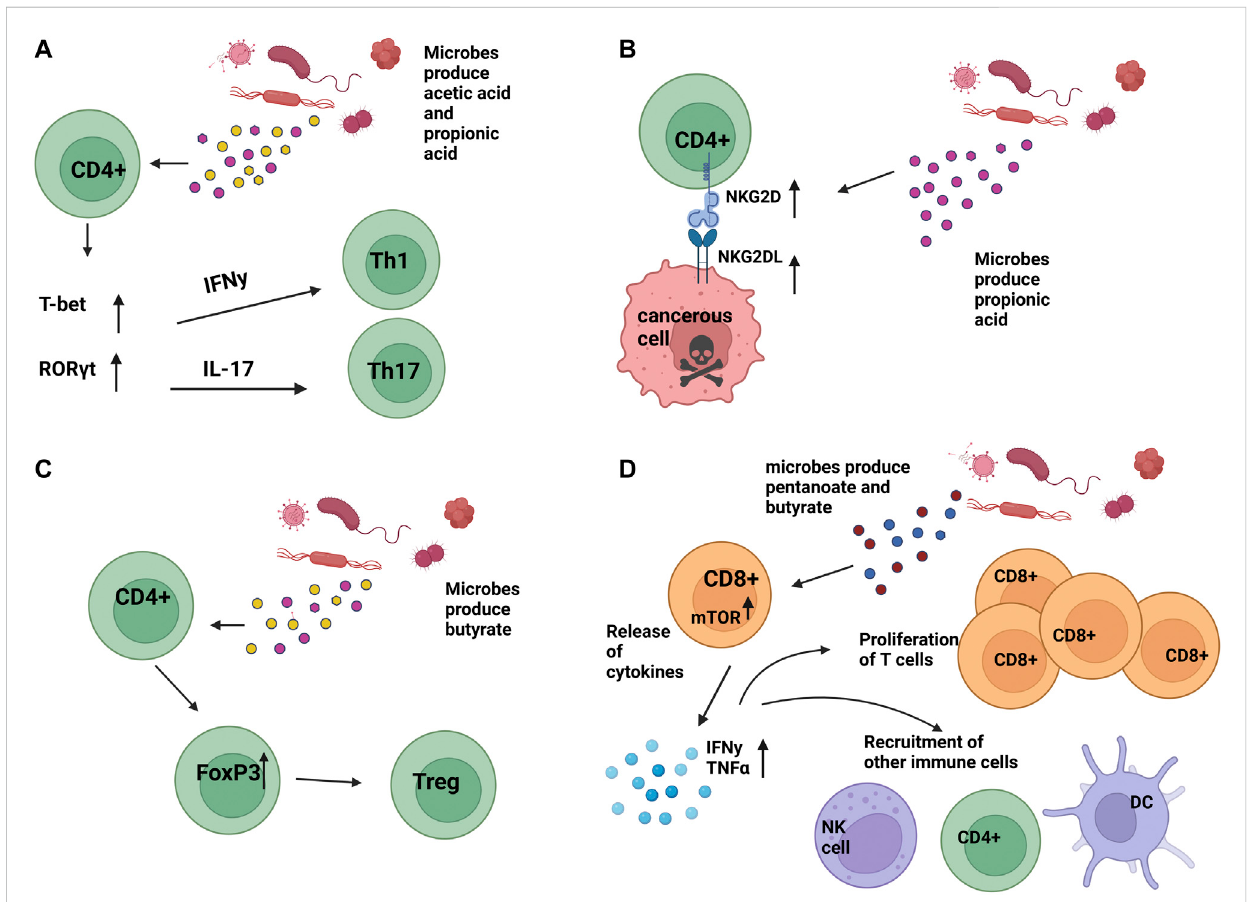
FIGURE 2 Impact of microbial secreted metabolites on T cell function (A) . Bacterial-produced acetic acid (C2) and propionic acid (C3) can result in upregulation of T-bet and ROR γ t, causing upregulation of IFNy and IL-17 and subsequent differentiation into Th1 and Th17 T cells, respectively. (B) . Microbialproducedpropionicacid(C3)hasresulted intheupregulationofNKG2D andNKG2DL onCD4 Tcells, CD8Tcells, andNKcells, contributing to an anti-tumoral environment and death of cancer cells. (C) . Microbial-produced butyrate has been shown to cause the differentiation of T-regulatory cells (Tregs) in a concentration-dependent manner. (D) . Microbial-produced pentanoate and butyrate have been shown to contribute to increased CD8 T cell effector functions. Image created with BioRender.com